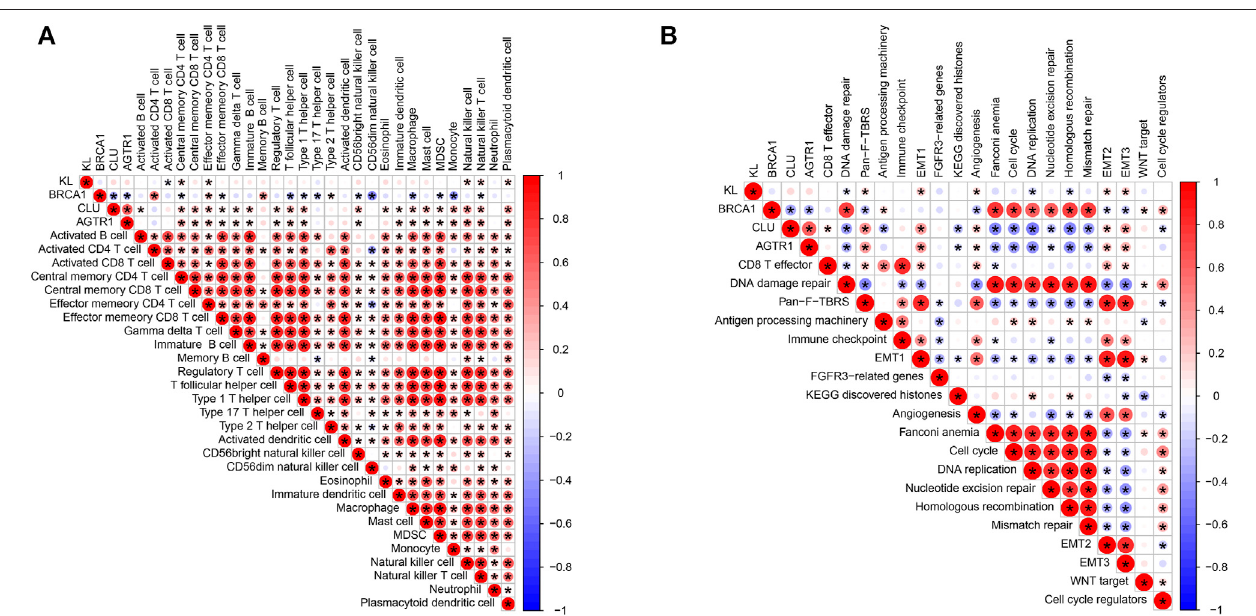
FIGURE 8 | Association of BRCA1, CLU, AGTR1, and KL with tumor-in fi ltrating immune cells and known biological processes. (A) Spearman correlations of BRCA1, CLU, AGTR1, and KL with tumor-in fi ltrating immune cells across rectal cancer. (B) Spearman correlations of BRCA1, CLU, AGTR1, and KL with known biological processes across rectal cancer. The bigger the bubble, the stronger the correlation. Red means positive correlation, and blue means negative